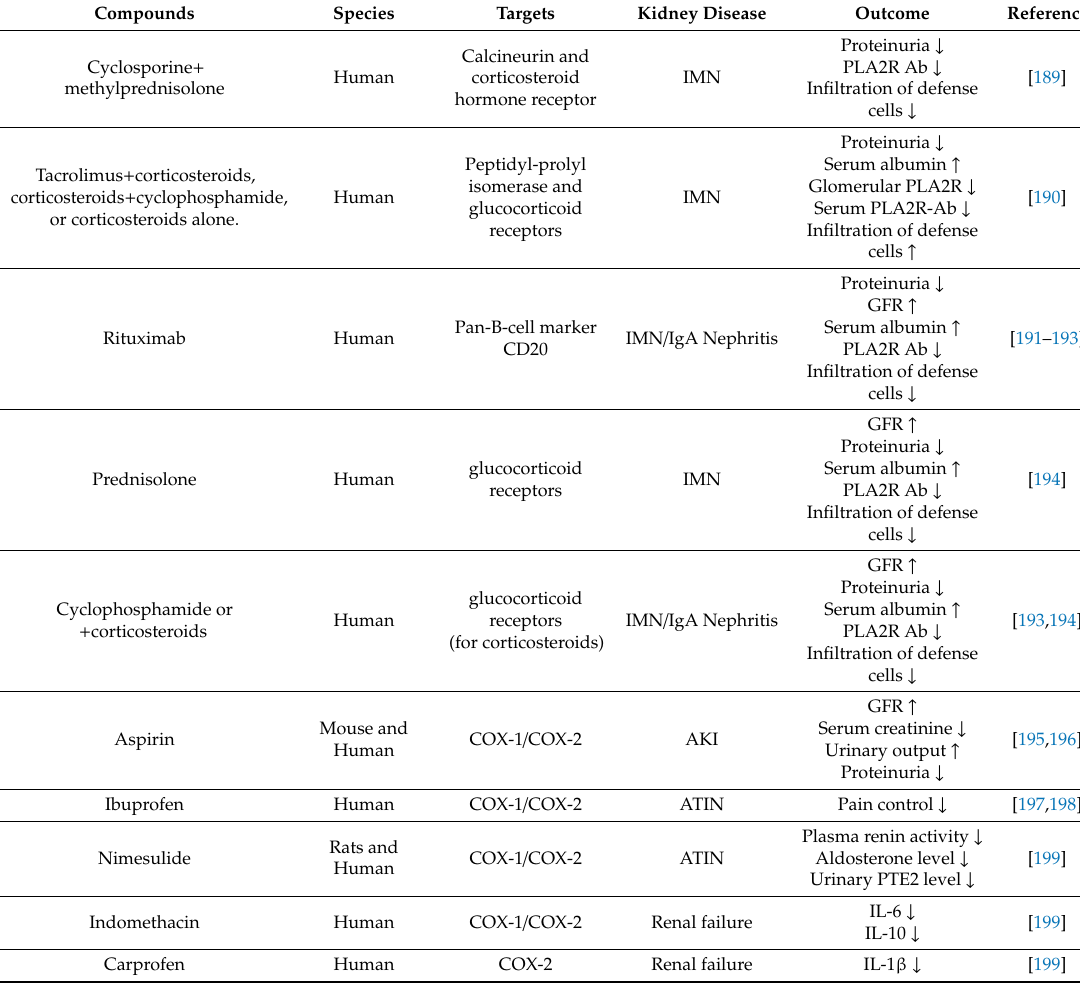
Table 1. Drugs related to AA metabolism for kidney